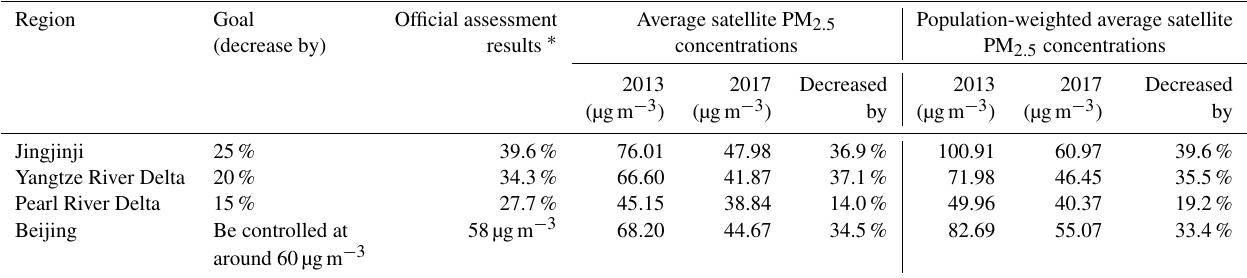
Table 4. Goals and accomplishments of APPC-AP (2013–2017). Region